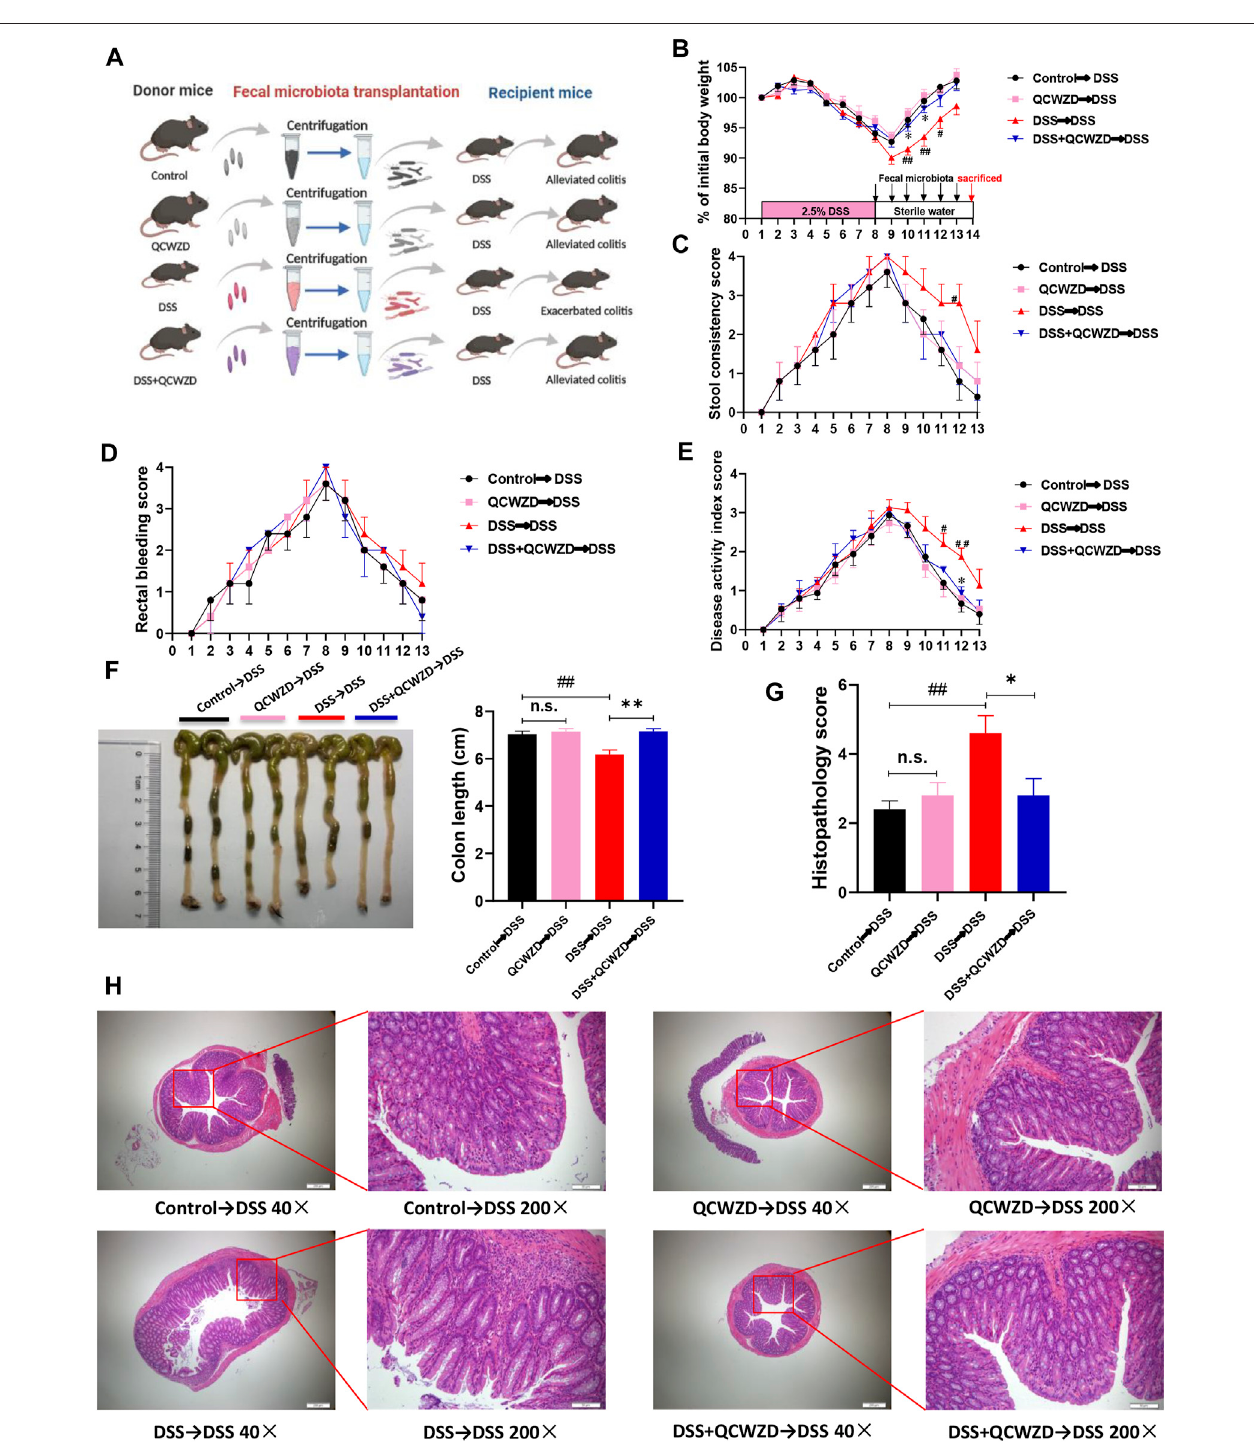
FIGURE 4 | The Protective Effect of QCWZD are Transferable by Fecal Microbiota Transplantation. The feces were collected from the donor mice at the indicated time points and orally gavaged to the corresponding recipients (Control → DSS, QCWZD → DSS, DSS → DSS and DSS+QCWZD → DSS) pretreated with a 7-day DSS solution, then the growth performance and the severity of colitis of all mice were evaluated. (A) Study design of fecal transplant experiment. (B) Body weight. (C) Rectal bleeding. (D) stool consistency. (E) Disease activity index (DAI) score, (F, G) Colon and colonic length, (H, I) Hematoxylin and eosin (H&E) staining ofthe colon and Histological score. (J) MPO activity. The data shown are the mean ± the SEM ( n (cid:2) 5mice/group). ## p < 0.01, # p < 0.05 versus the Control → DSS group; pp p < 0.01, p p < 0.05 versus the DSS → DSS group. Signi fi cance was determined by one-way ANOVA test (Tukey ’ s multiple comparison test).